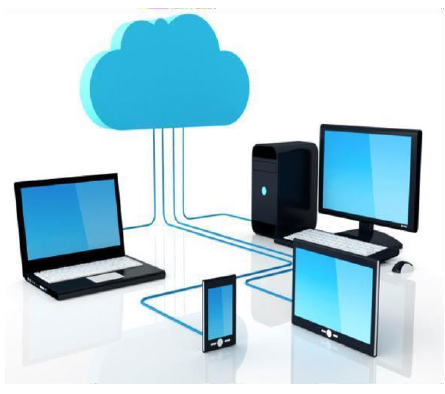
Figure 1. Cloud Access